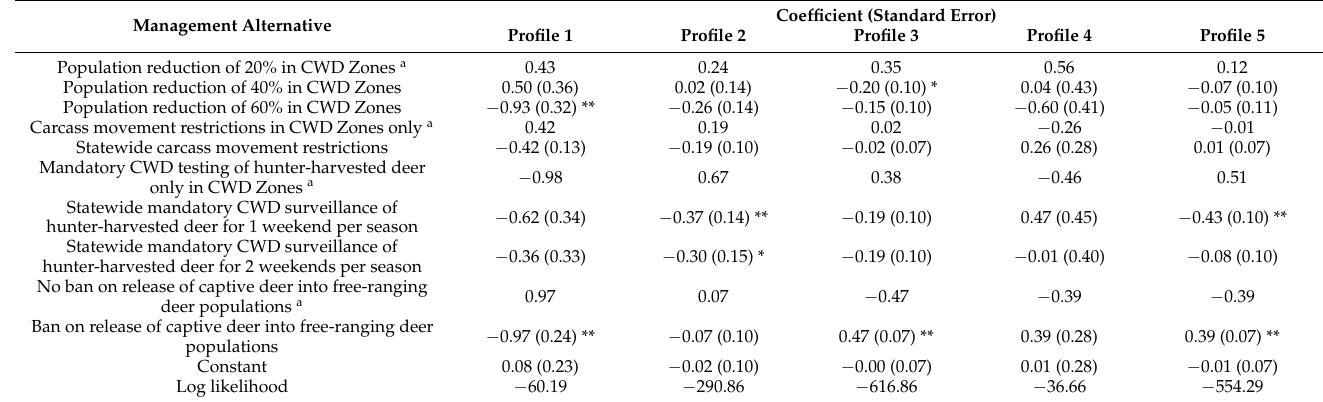
Table 4. Logit model results of Texas hunter CWD management preferences by latent profile